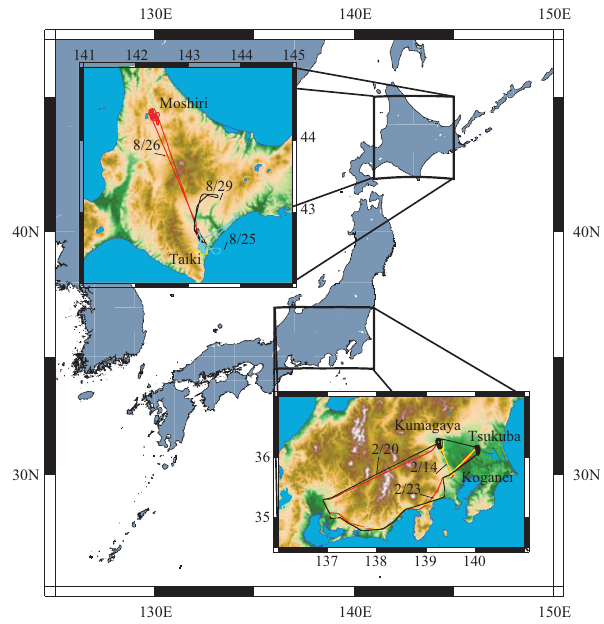
Fig. 3. Flight paths of the aircraft measurements in August 2009 (top panel) and February 2010 (bottom